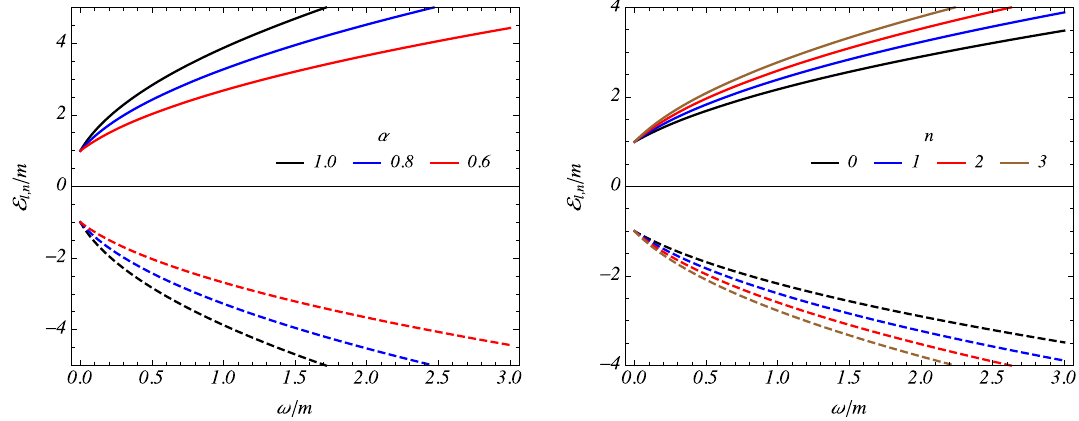
Fig. 3 Energy profile of the KGO as function of ω/ m . In the left plot we have different values of α and n = 1, while in the right plot we consider α = 0 . 5 and different energy levels. Also l = 0 and ξ = 0 in both plots. The full and dashed curves represent the positive and negative energies,